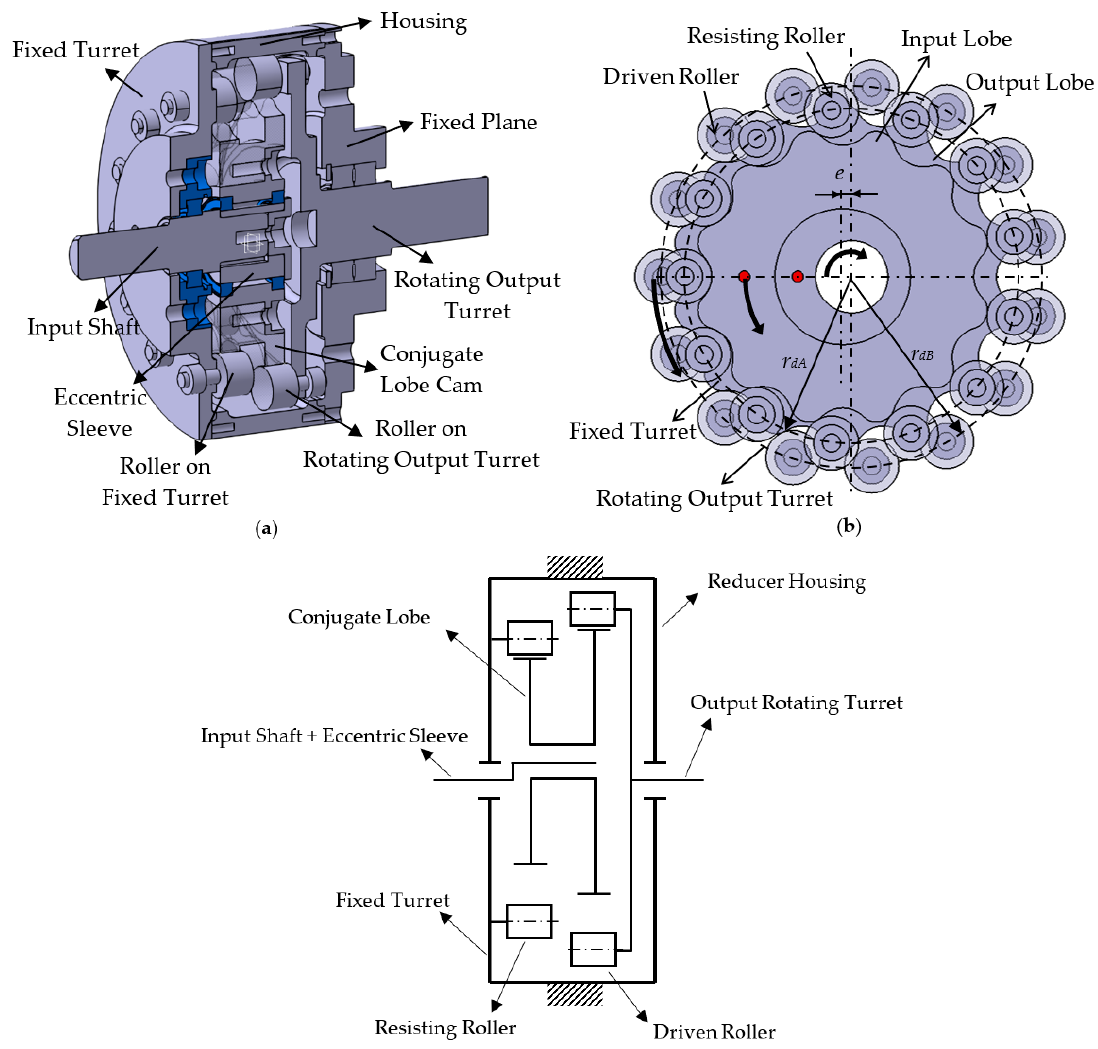
Figure 1. Structure of the conjugate lobe cam reducer: ( a ) section view; ( b ) schematic illustration of the conjugate lobe cam and rollers; ( c ) kinematic scheme.